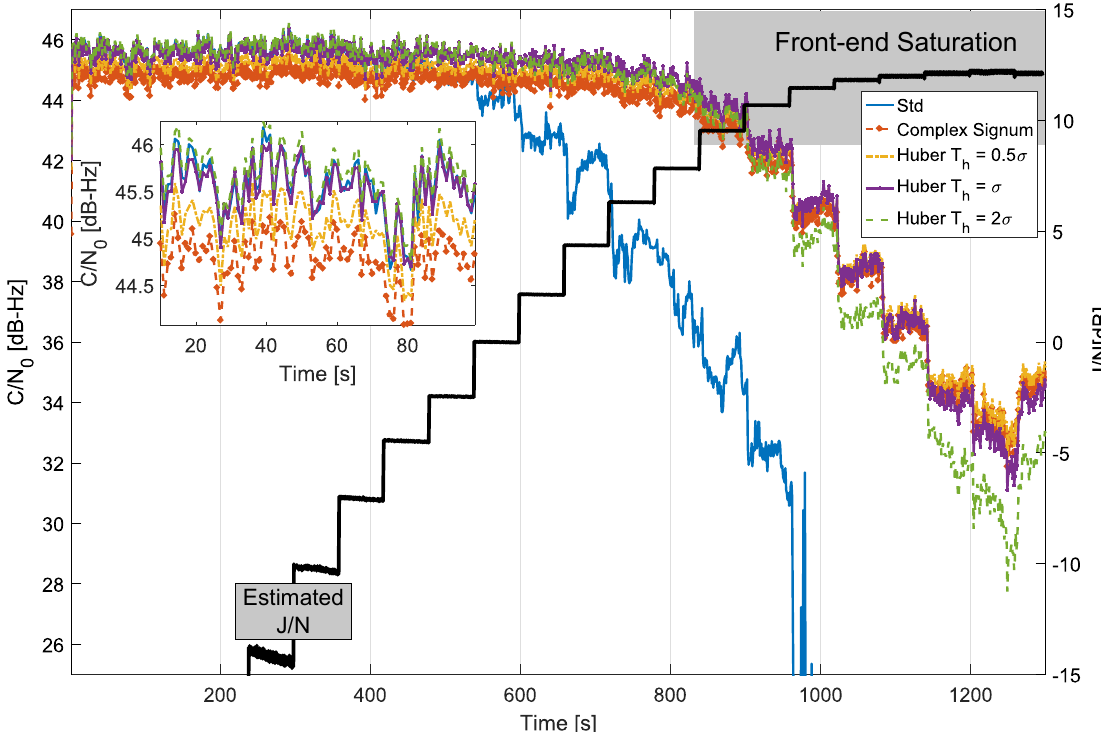
Figure 10. Comparison of C / N 0 values obtained considering different frequency domain processing schemes. Anechoic chamber test with GPS